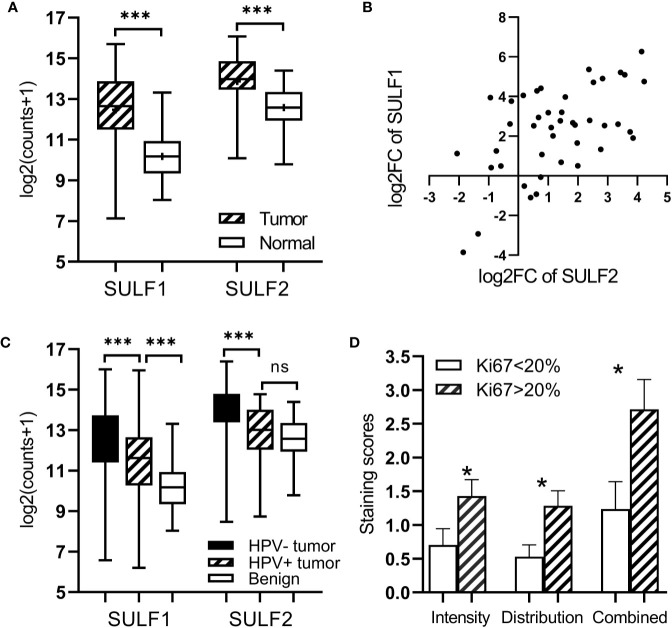
Expression of SULF1 and SULF2 in HNSCC tumor and adjacent tissues: (A) Upregulated SULF1 and SULF2 mRNA in tumor compared to benign tissues in patients from TCGA (p < 0.001 for both SULFs, n = 43, paired t-test). (B) Correlation of fold change between tumor and benign tissues for SULF1 and SULF2 in patients from TCGA (r = 0.563, p < 0.001, n = 43, Pearson correlation). (C) SULF1 and SULF2 mRNA in tumors from the TCGA study vary by HPV status (p < 0.001 for both, n = 335, one-way ANOVA). (D) IHC staining of SULF2 protein in tumor varies by percent of Ki67 IHC staining FFPE tumor sections (n = 40). * is 0.01<p<0.05, *** is p<0.001.